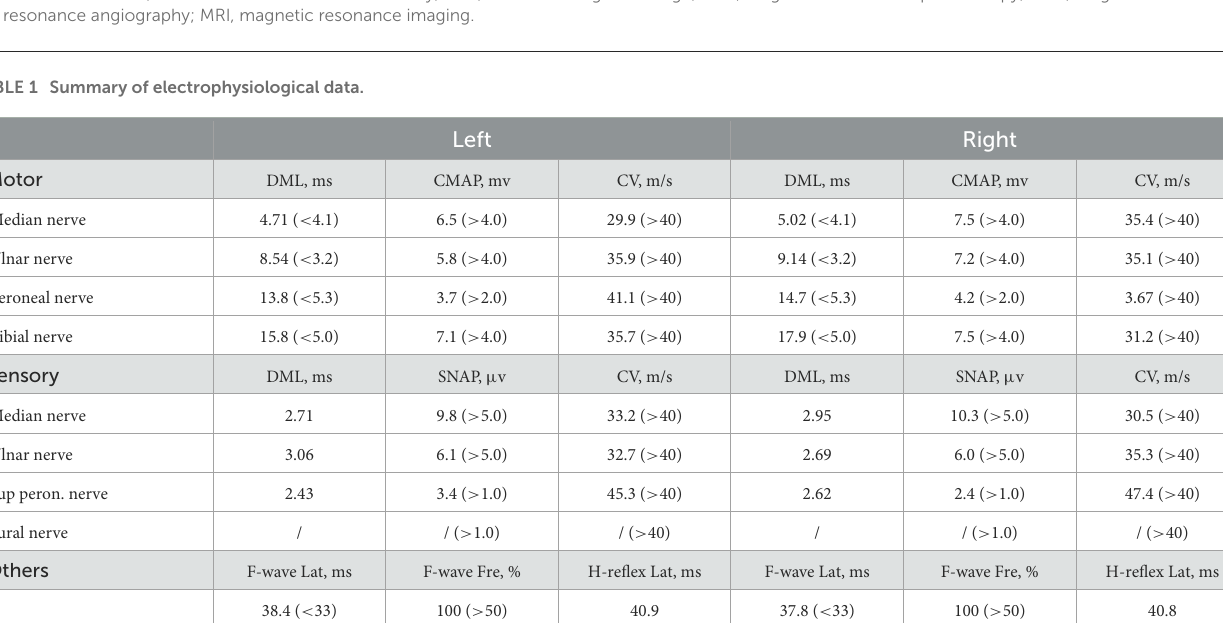
TABLE 1 Summary of electrophysiological data.